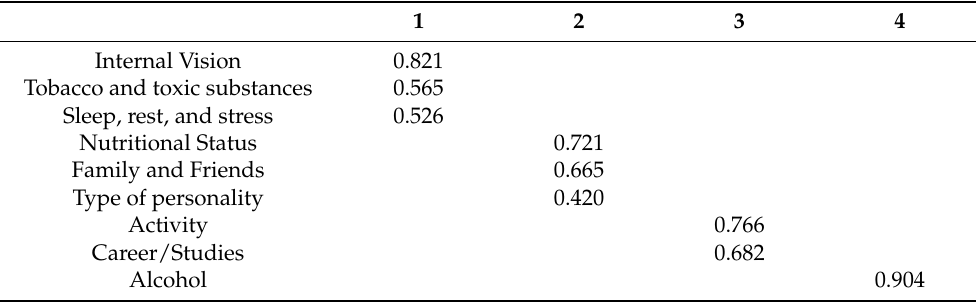
Table 4. Rotated matrix of components (own